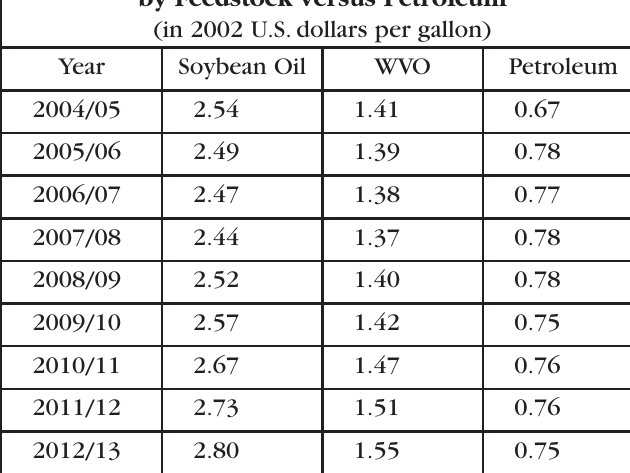
Table 1. Forecasted Production Costs for